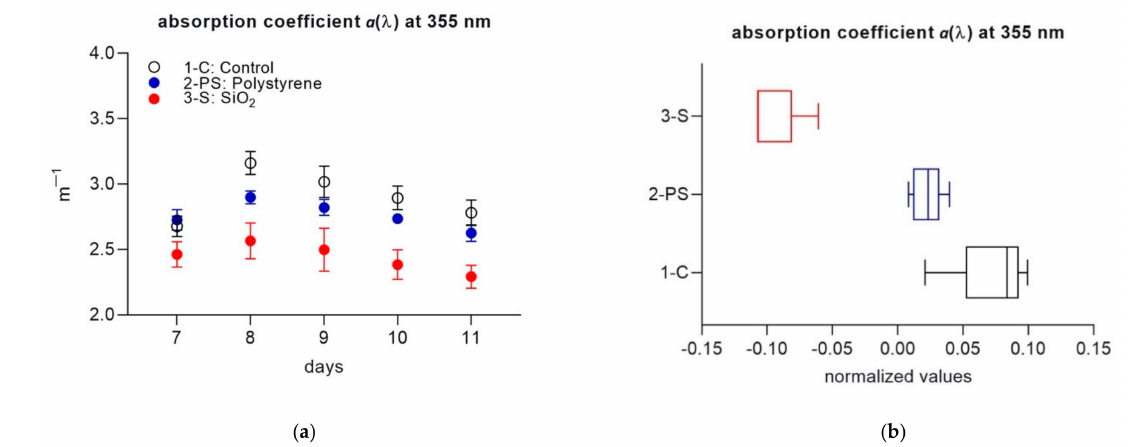
Figure 2. ( a ) Daily a (355) values per treatment during experimental part 2. Each data point is the average of four replicate cuvettes ( ± standard deviation); ( b ) normalized daily anomalies per each treatment during experimental part 2. Box plots have the following color code: 1-C (black line), 2-PS (blue line) and 3-S (red line).